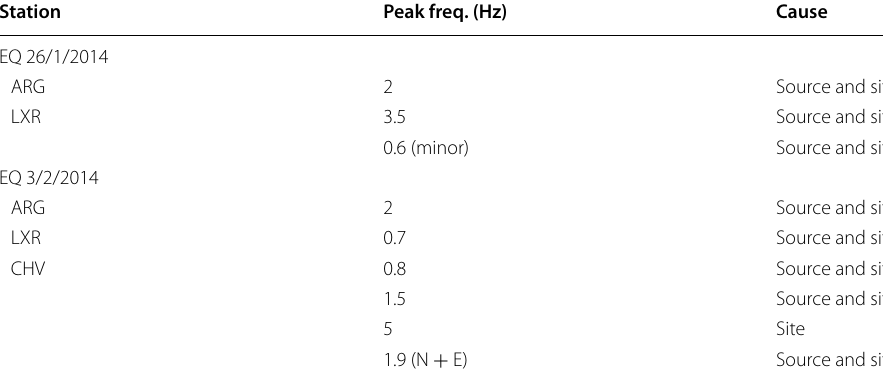
Table 3 Interpretation of the HVSR of strong ground motion with respect to the theoreti- cal seismic energy radiation pattern deduced from moment tensors of the 2014 Cephalo- nia earthquake sequence (see Fig. 9)